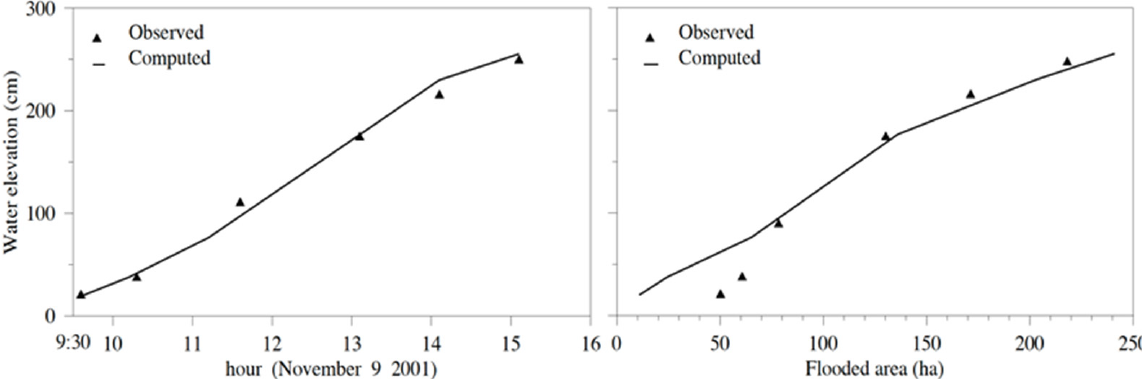
Figure 10. Comparison between the OCRE-FVCOM-simulated and remote sensing-observed water elevations (left panel) and flooded areas (right panel) in the Okatee tidal creek during the flood–tidal period on 9 November 2001.